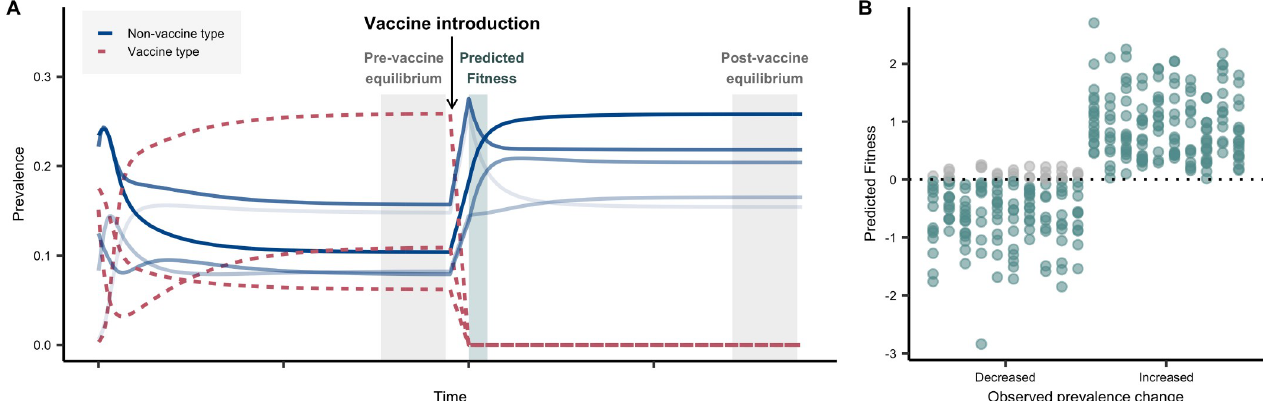
Fig 2. Simulations. A. Conceptual diagram for simulations. Descriptive representation of the strain prevalence at different stages relative to vaccine introduction: pre-vaccine equilibrium, vaccine introduction, and post-vaccine equilibrium. We modeled a population of VT and NVT strains (represented as unique genotypes with alleles 1 or 0 at a locus, denoting the presence or absence of a single accessory locus) and simulated the removal of VT genotypes, following the post-vaccine population to equilibrium (details in methods). In this illustrative figure, 8 strains are shown, with their prevalence in the population evolving over time. The system is allowed to evolve until it reaches a steady state (“pre-vaccine equilibrium”). Three strains were then targeted to mimic a vaccine introduction, which removes them from the system. The predicted fitness was then estimated from the period just after the vaccine introduction, when the population has been depleted of VT but relative prevalence of NVT has not changed—a quantity that can be calculated from pre-vaccine data alone. Finally, the system reaches a second steady state (“post-vaccine equilibrium”). Different shades of blue represent the rank of the strain frequencies in the post-vaccine equilibrium. B. Predicted fitness. Comparison of the direction of prevalence change of strains from pre- to post-vaccine using simulated data and predicted fitness from these simulated data. For these 10 replicate simulations, 2,371 accessory loci and 35 randomly chosen strains were simulated, including 3 VT genotypes. For each replicate, the pre-vaccine equilibrium frequencies of the 2,371 accessory loci were varied. Final prevalence of strains was obtained by quadratic programing, and prevalence change for each NVT strain was calculated as post-vaccine prevalence minus pre-vaccine prevalence, in both cases with all NVT strains summing to 100%. Each column in the decreased and increased category represents the results from 1 simulation (i.e., the first column in the decreased category corresponds to the first column in the increased category, and the dots sum to 32). The predicted fitness of the strain accurately predicts the direction of the prevalence change in 92.8% of cases (teal dots). Gray dots represent instances in which the direction of the prevalence change was not predicted correctly in the simulation. See S1 Data and S1 Code for details. NVT, nonvaccine serotype; VT, vaccine serotype.